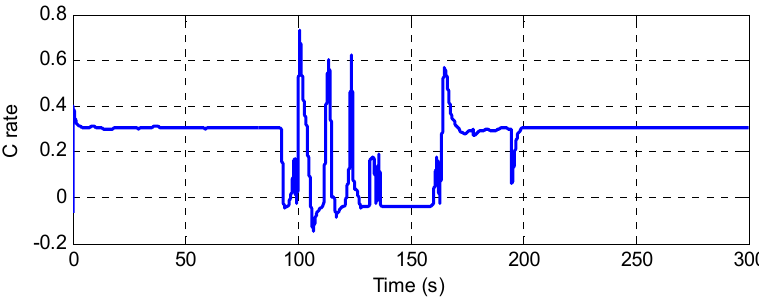
Figure 21. C rate of battery for Case 3.